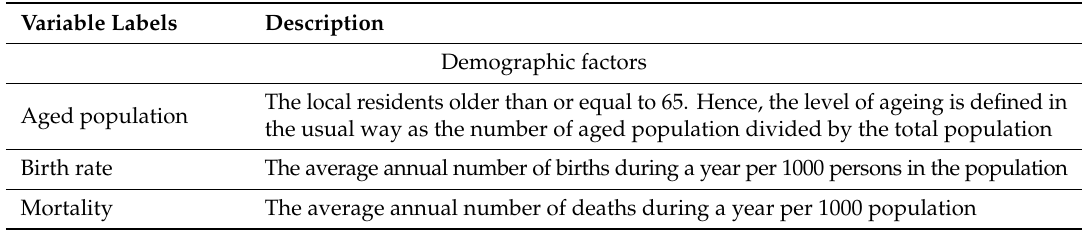
Table 1. Definitions of